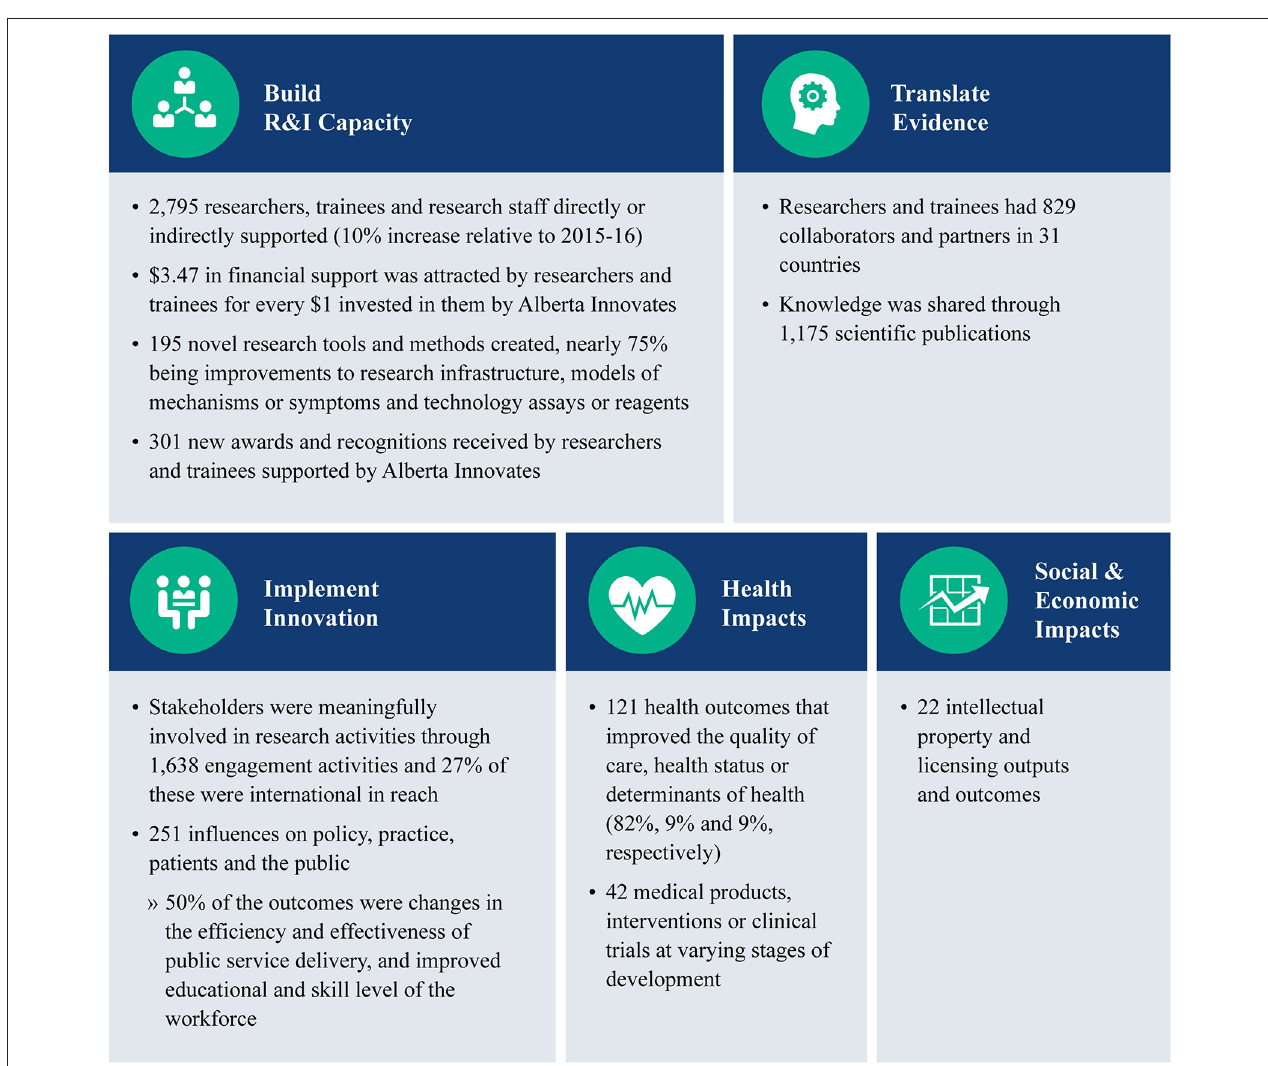
FIGURE 3 | Sample of Alberta Innovates’ Health Innovation Impacts: